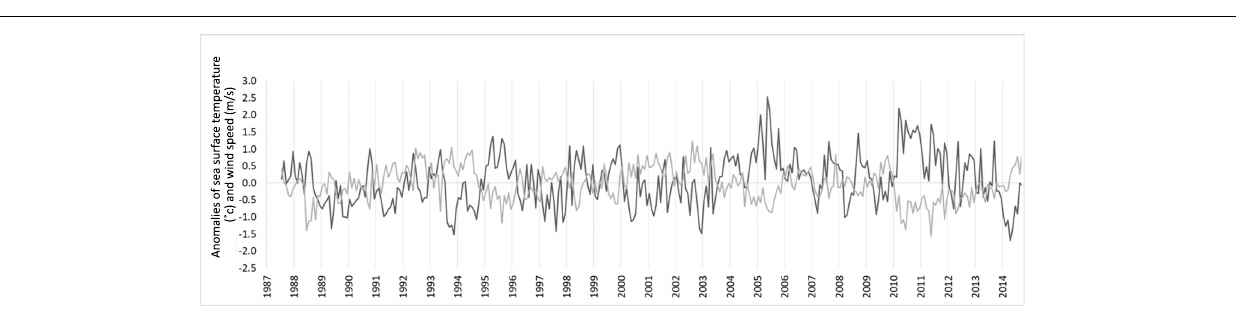
FIGURE 4 | Relationship between the interannual variation of the upwelling intensity (expressed as the SST anomalies; black line) and the wind intensity anomalies (gray line) (data provided by Rueda-Roa, Institute for Marine Remote Sensing, University of South